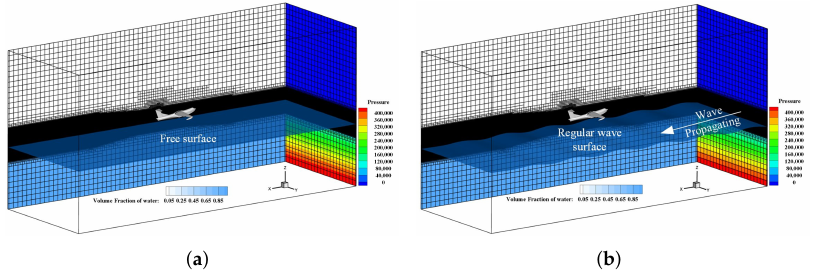
Figure 2. Computational domain and initial flow field of aircraft water-landing simulation: ( a ) calm water-landing; ( b ) regular wave